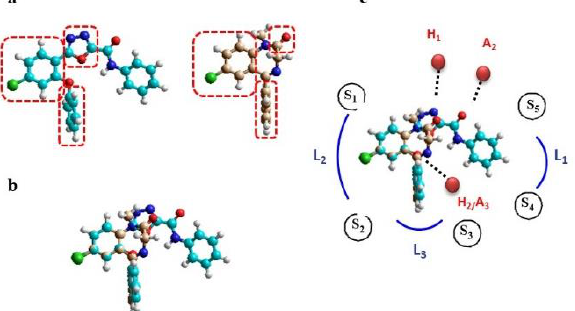
Figure 1: a : The structures of the designed com- pound ( 6a ) and diazepam. The main pharmaco- phores have been conserved. b : Stereo view of the superimposition of the energy minima con- formers of diazepam and compound 6a . c : Super- imposition of diazepam and compound 6a located in the model suggested by Cook and co-workers (Zhang et al.,